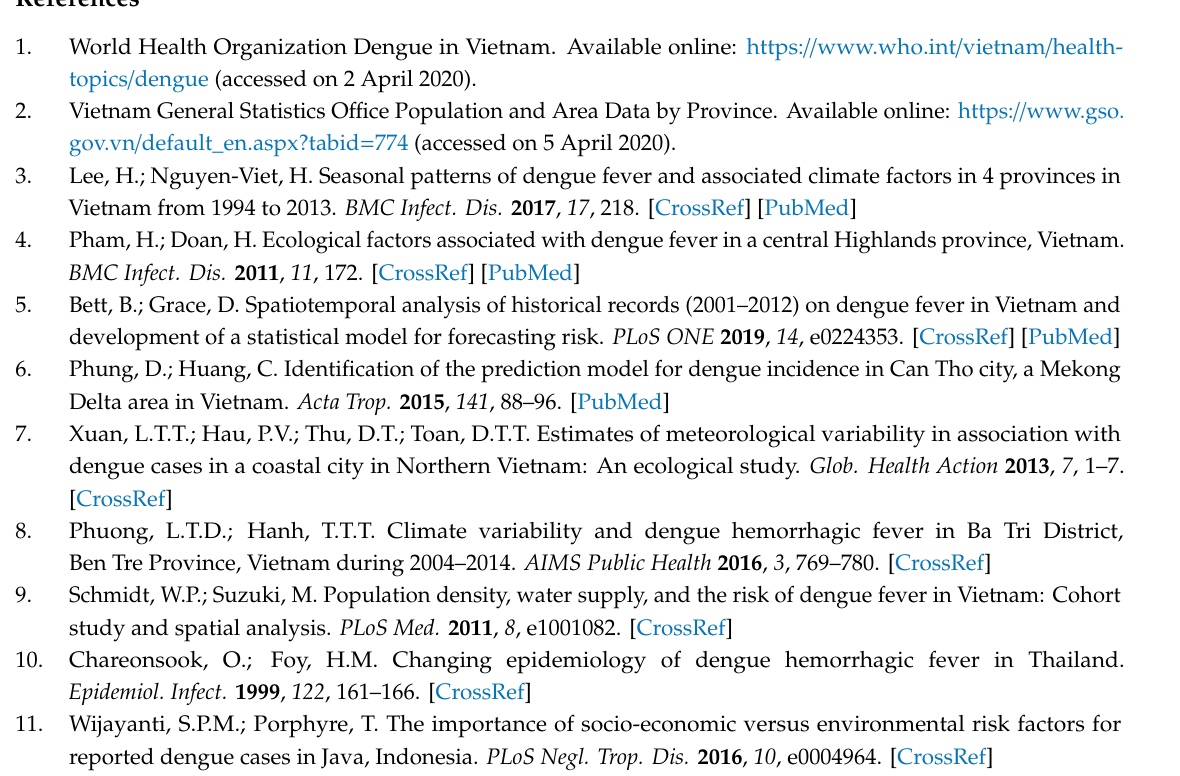
Figure S1: Moran’s I graphs demonstrating cross-provincial spatial autocorrelation for second order queen contiguous neighbours, 2011–2015. Table S1: Summary statistics, dengue case counts 2013–2015. Table S2: Definitions, units, rationale and source of socioeconomic exposures (annual province-level data for the years 2013–2015 inclusive). Table S3: Vietnam country population summary statistics. Table S4: Summary statistics for spatiotemporal exposure variables 2011–2015 (2.d.p.; see Table 2 for variable descriptions). Table S5: Correlation coe ffi cients matrix, spatiotemporal variables (2.d.p.; see Table 2 for variable descriptions). Table S6: Summary Table S8: Results of the Hausman test for socioeconomic variables (2.s.f.). Table S9: Pregibon’s test results for candidate models (see Table 2 for spatiotemporal variable descriptions). Table S10. Summary of potential candidate model regression outputs (2.s.f.; see Table 2 for description of spatiotemporal variables). Author Contributions: Conceptualization, P.A., J.F.L., G.F.M.; Methodology, P.A., G.F.M., J.F.L.; Software,